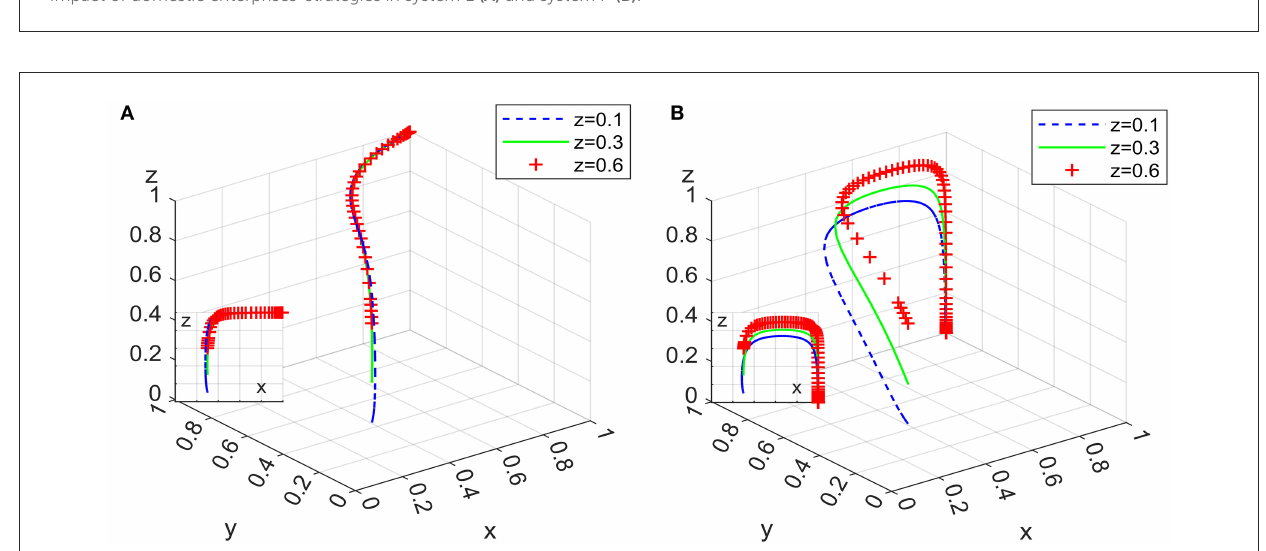
FIGURE8 Impact of governmental departments’ strategies in system L (A) and system P (B)